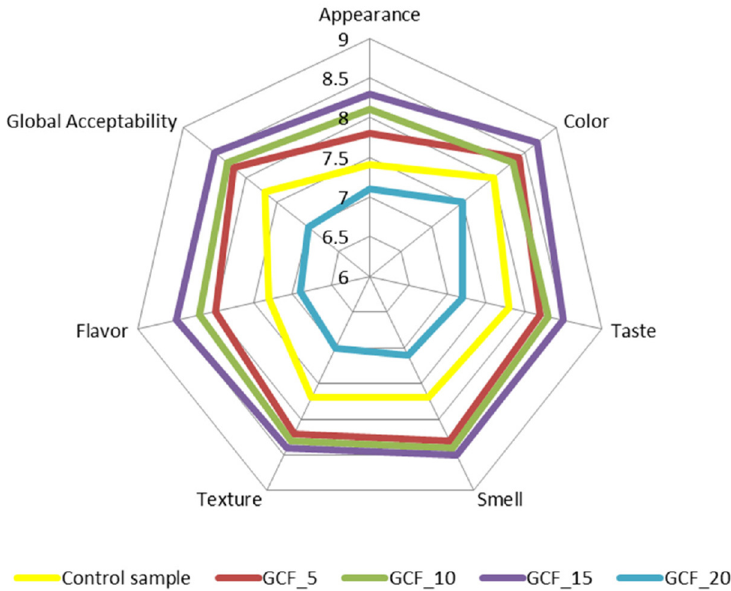
Figure 5. Sensory analysis for bread samples .